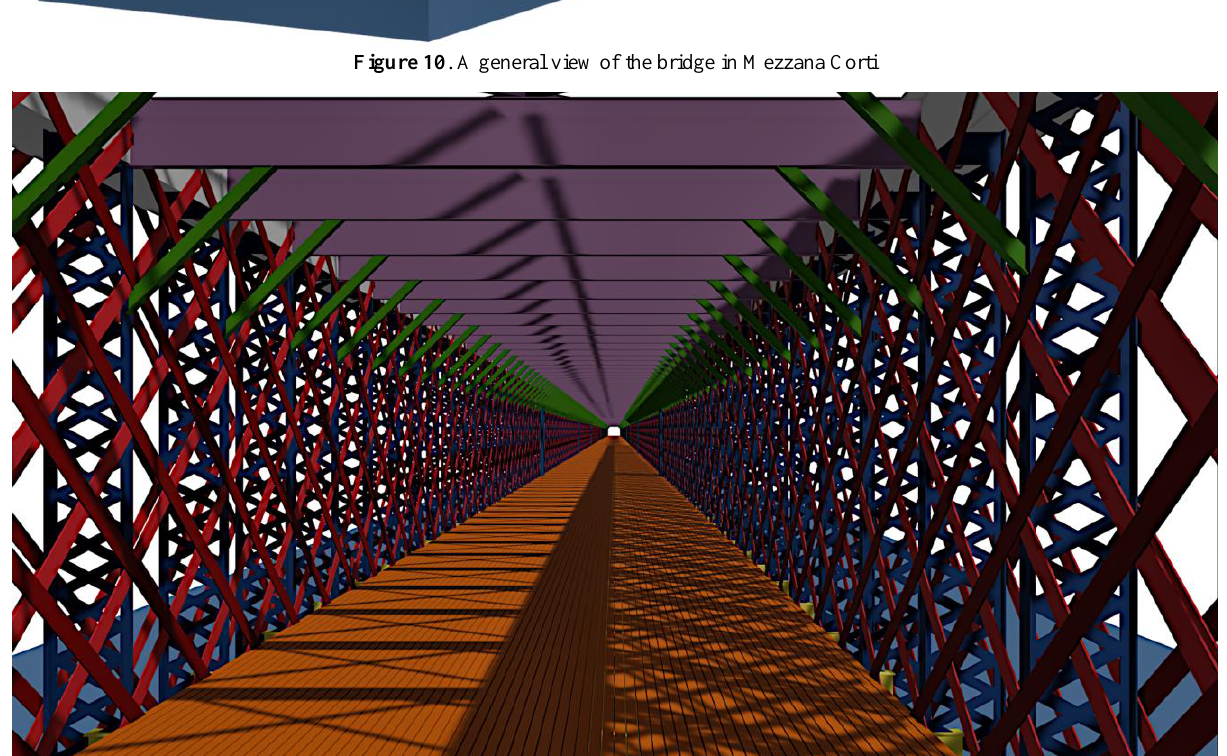
Figure 11 . A view of the bridge in Mezzana Corti; vertical struts were trellis, diagonal members were juxtaposed plates, bracing were Tee sections and the floor consists of wood.